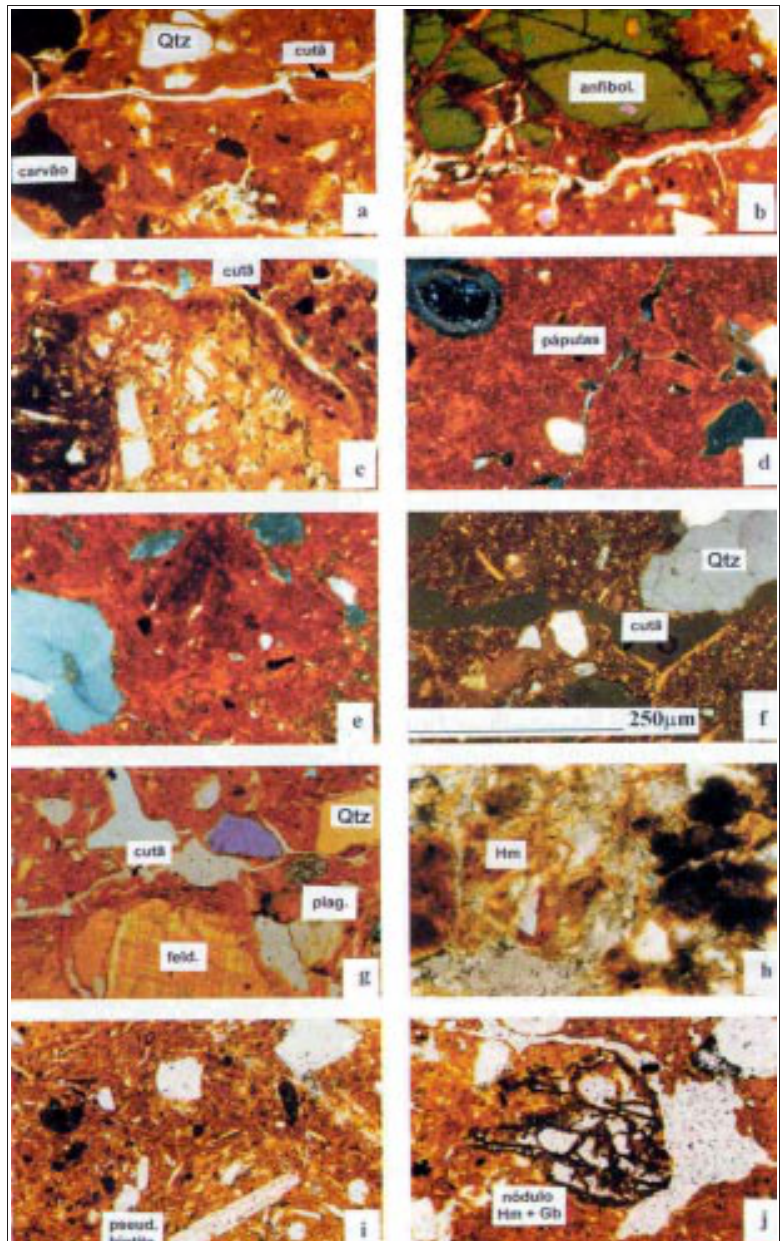
Figura 3. Fotomicrografias de horizontes de solos com horizontes Bt e Cv. Todas estão na mesma